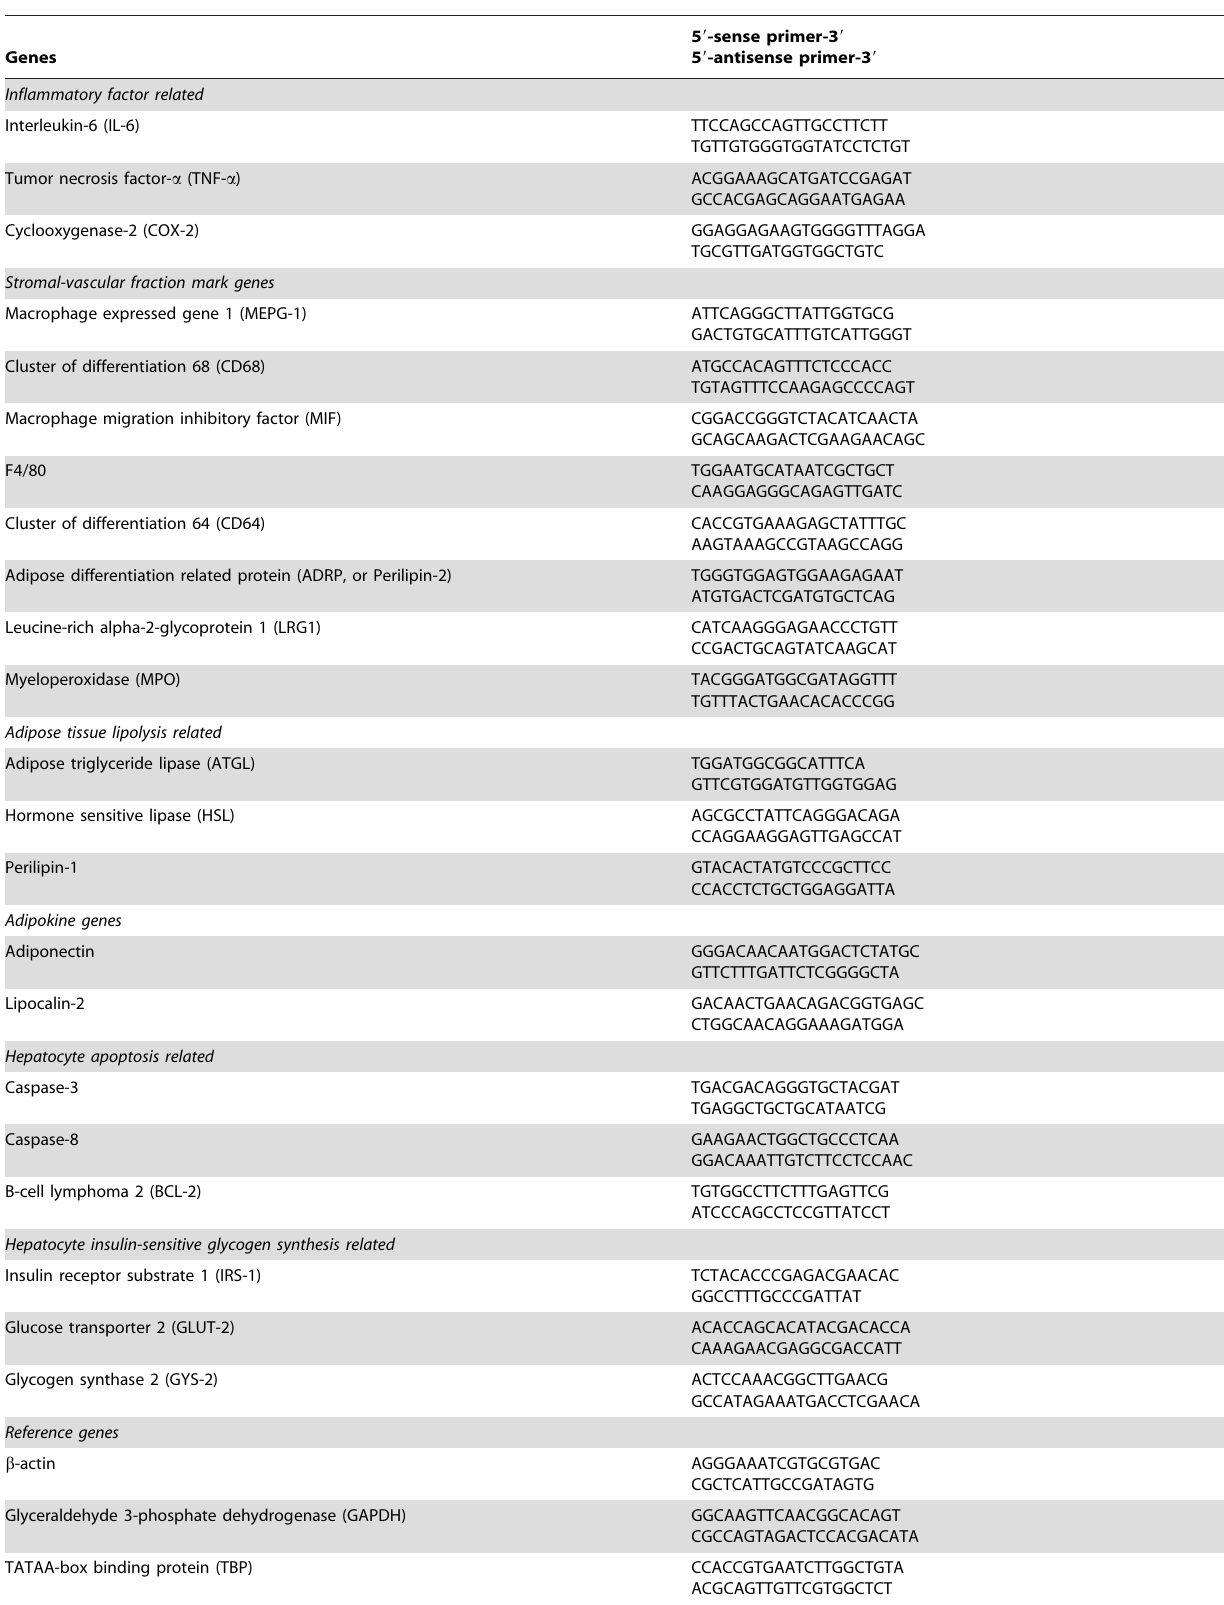
Table 1. Primers used for analysis of gene expression.